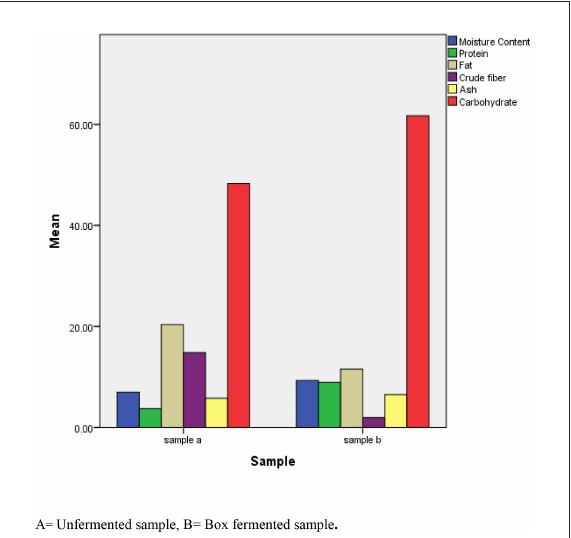
FIGURE9 Proximate composition of fermented and unfermented cocoa.